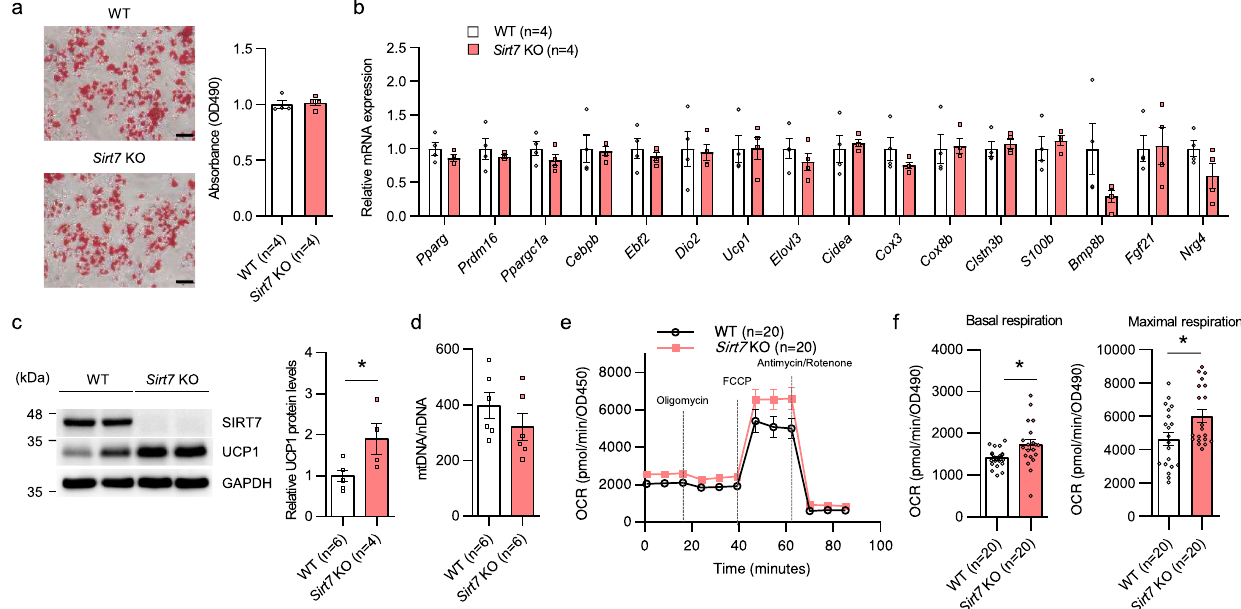
Fig. 6 | SIRT7 cell-autonomously suppresses mitochondrial respiration via a reductionin the UCP1protein level in brown adipocytes. a Oilred O staining of differentiated primary brown adipocytes from WT and Sirt7 KO mice (left panel, scale bar=50 μ m), and quanti fi cation of the stained oil red O (right panel). b Real- timeqPCRanalysisofBAT-relatedgenesinthecellsdescribedin( a ). c Westernblot analysis of UCP1 in the cells described in ( a ) (left panel), and quanti fi cation of the UCP1 protein bands relative to GAPDH control (right panel). p =0.0307.